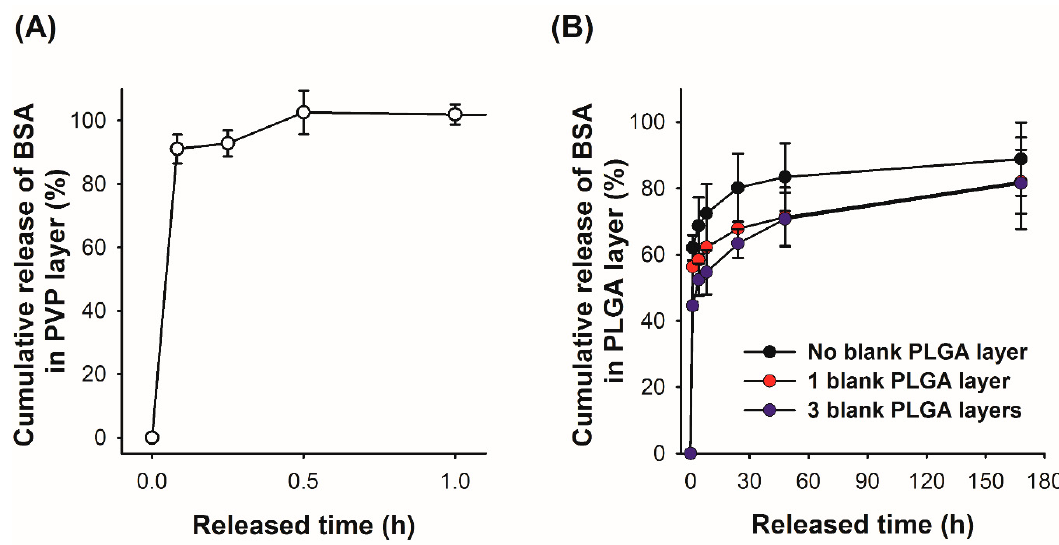
Figure 6. Cumulative release profile of BSA in ( A ) the PVP layer and ( B ) the PLGA layer without/with a PLGA diffusion barrier layer.